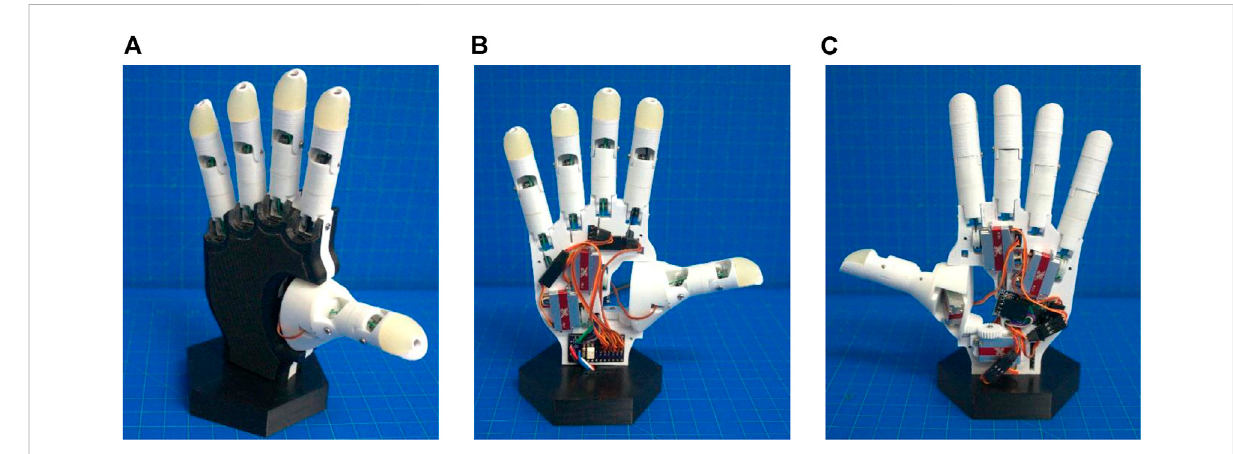
FIGURE 4 The BEAR PAW: A pediatric multiarticulate prosthetic hand with six degrees of actuation and programmable hand grasp con fi gurations. Shown in an isometric (A) , front (B) , and back (C)